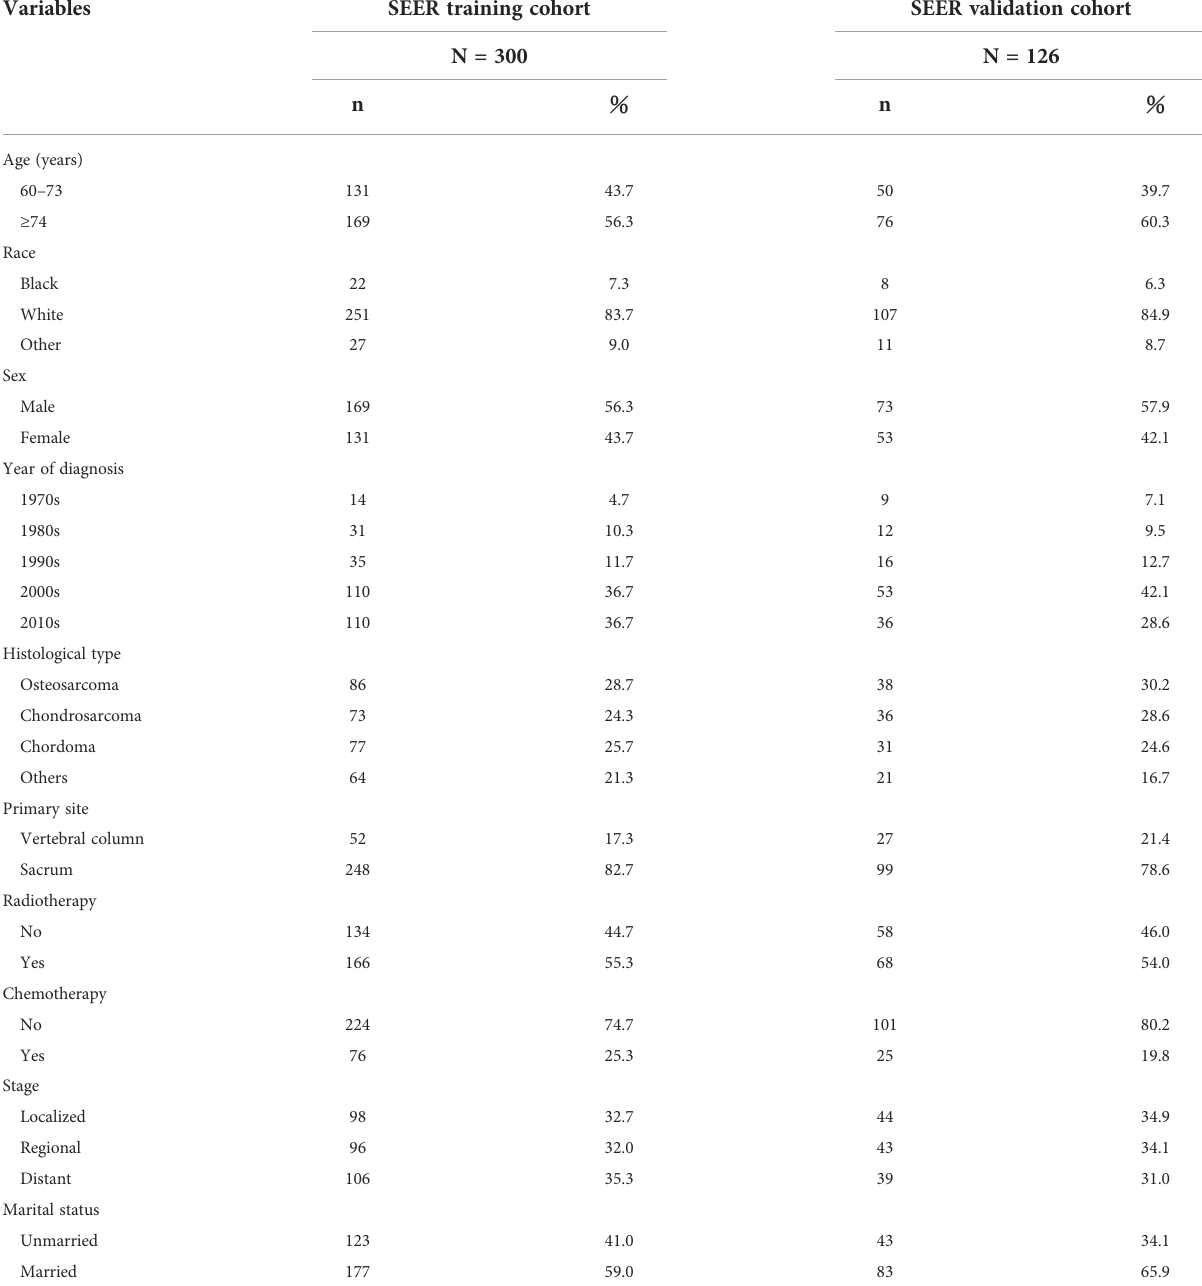
TABLE 1 Clinical and pathological characteristics of elderly patients with primary spinal tumors who have not undergone surgical treatment.